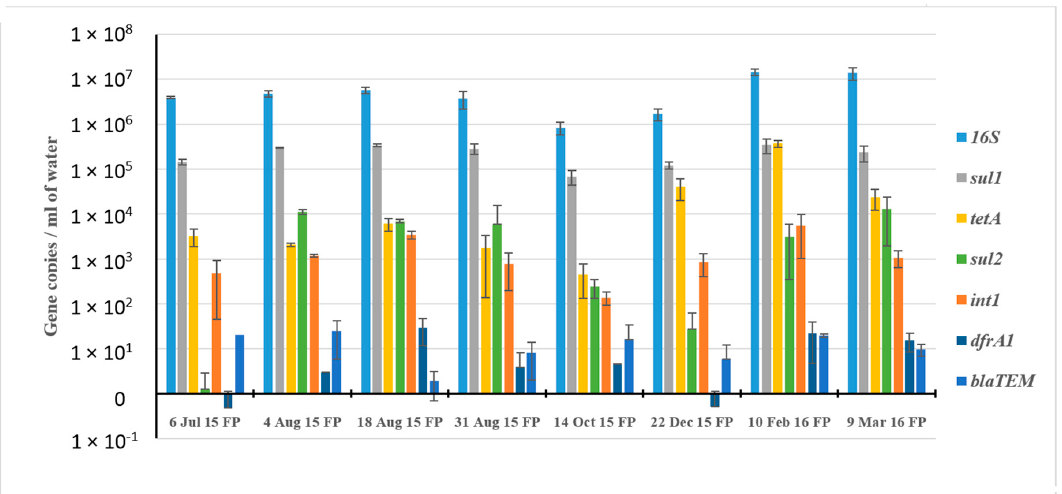
Figure 6. Abundance of selected qPCR-targeted ARGs in the FP-03 (FP) water